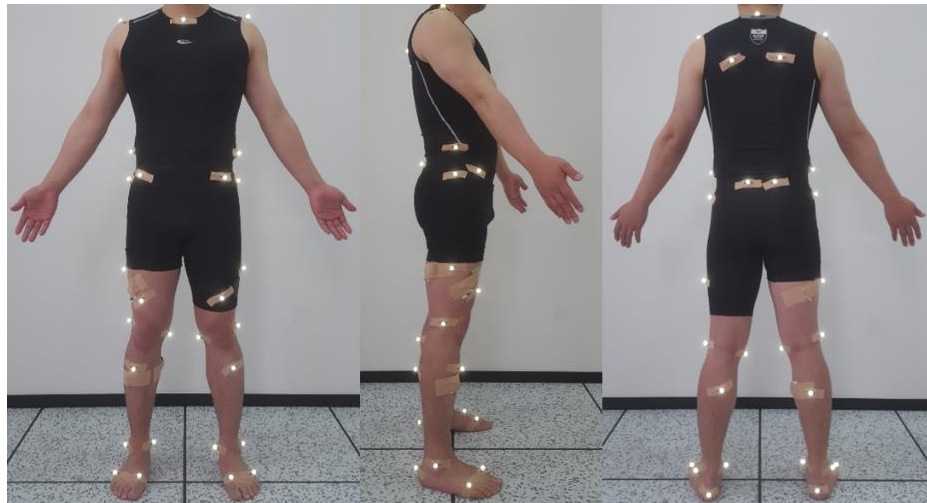
Figure 4. Location of the reflective motion capture markers.